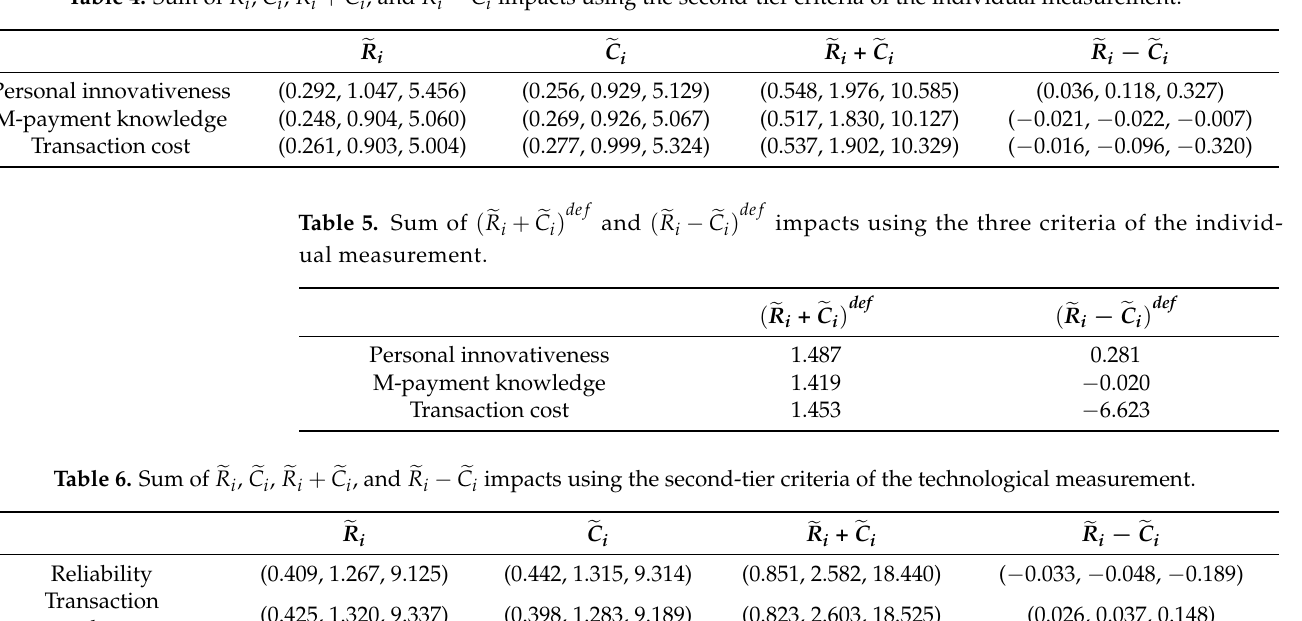
Table 4. Sum of (cid:101) R i , (cid:101) C i , (cid:101) R i + (cid:101) C i , and (cid:101) R i − (cid:101) C i impacts using the second-tier criteria of the individual measurement.